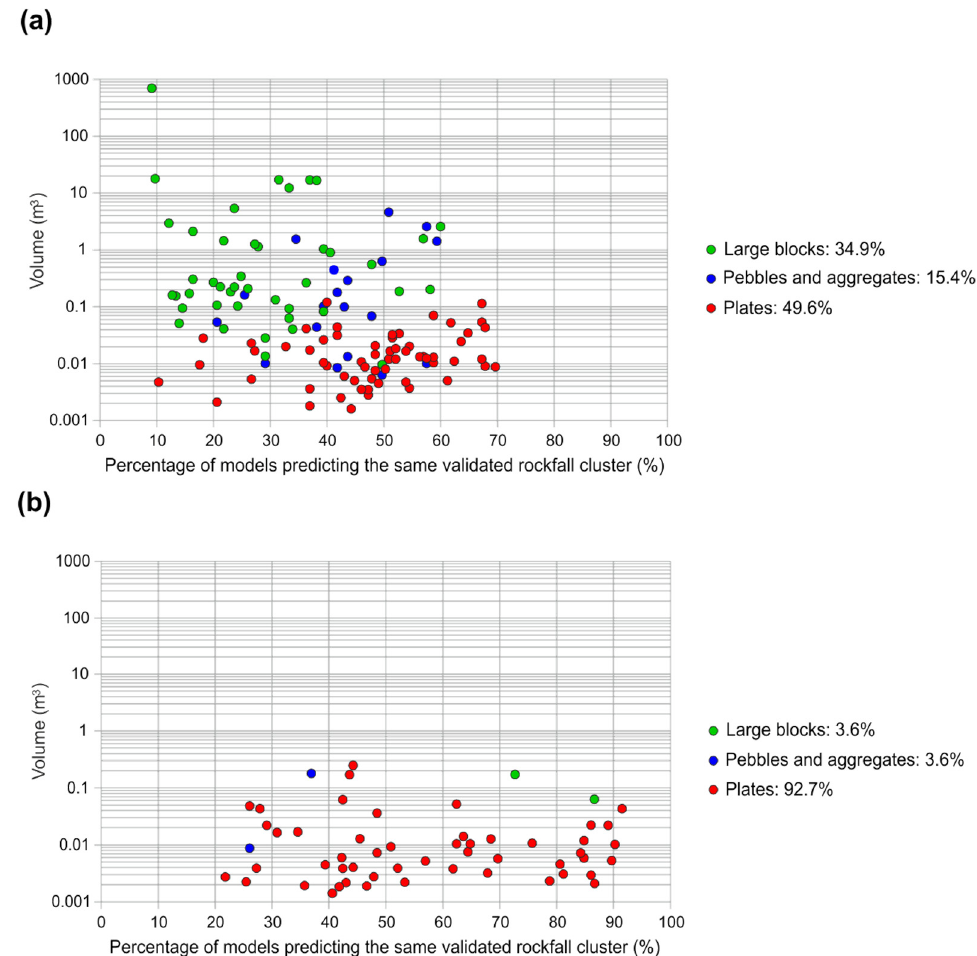
Figure 11. Relationship between the volume of the rockfall clusters, classes of rockfalls, and the percentage of models predicting the same validated rockfall clusters at the Degotalls. ( a ) Rockfall classes of Degotalls N are majority plates, usually associated with weathering processes with small volumes, and large blocks, due to the large detachment during the 2007–2009 period. Both classes define a heterogeneous scenario that gives rise to more difficulties in the training stage of predictive models. ( b ) Degotalls E presents a homogeneous class with small volumes that facilitate the identification of predictive models.